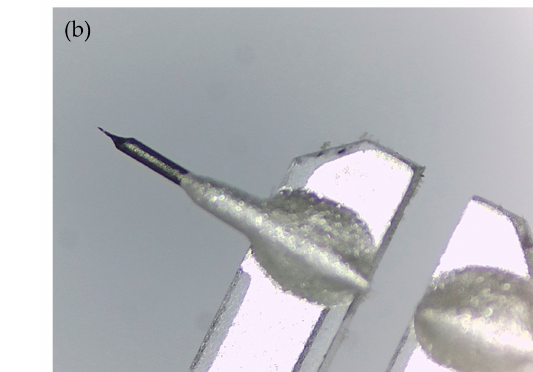
Figure 8. Q values of a balanced tuning fork probe: ( a ) Q value when the length of the tungsten tip is 1 mm; ( b ) Q value when the length of the tungsten tip is 3 mm. The Q value range of the tungsten-tip QTF probe prepared by the above method is generally between 1000 and 4000, and the Q value of the lighter silicon tip or the micro- machined tip can even reach 10,000. At present, there is no instrument or controller suit- able for a QTF probe with a Q value in the range of 1000~10,000 on the market. Therefore, we developed a tuning fork controller suitable for this Q value range for our homemade AFM control system to drive the QTF probe in an atmospheric environment. 2.2.2. Tuning Fork Pre-Circuit and Control The pre-circuit of the tuning fork probe consists of a QTF probe-driving circuit and a self-excitation and self-induction circuit, which is a closed circuit in the AFM scanning imaging state.